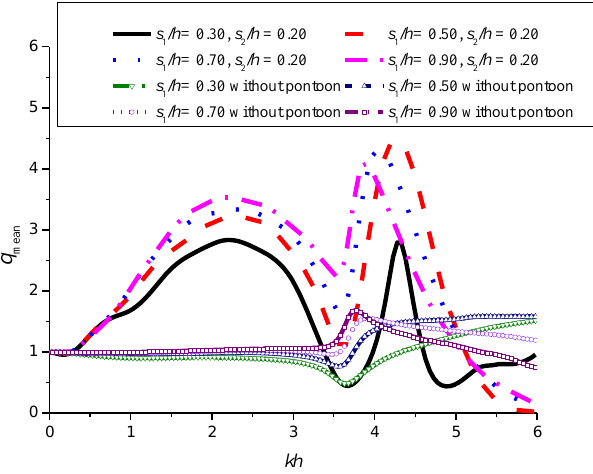
Figure 8. Variations of q mean with kh for WEC arrays with different WEC-WEC spacing of s 1 / h = 0.3, 0.5, 0.7, and 0.9. The WEC-pontoon spacing is s 2 / h = 0.2.